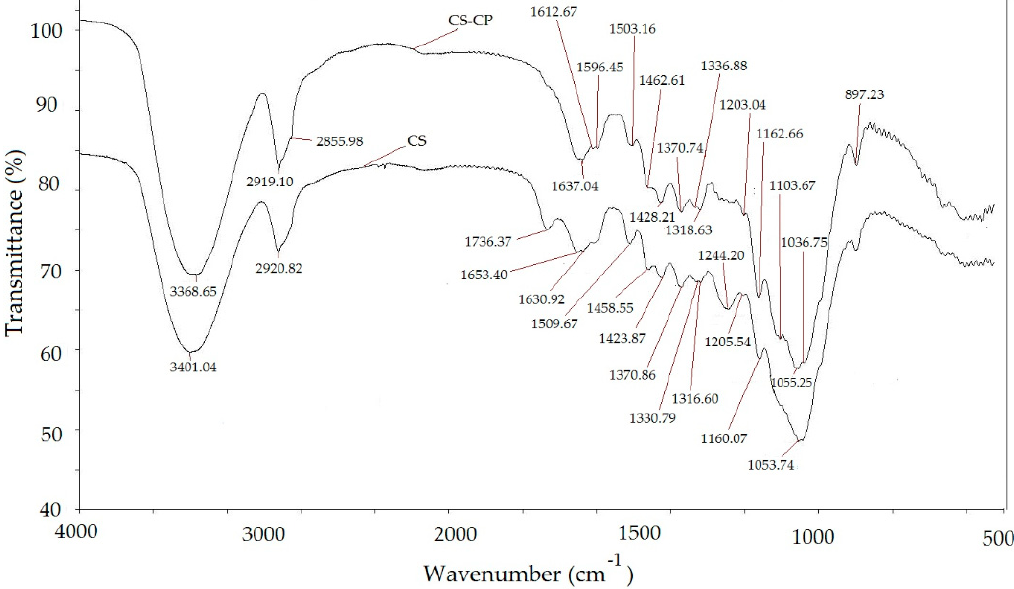
Figure 1. FTIR spectra for unmodified and modified CS.